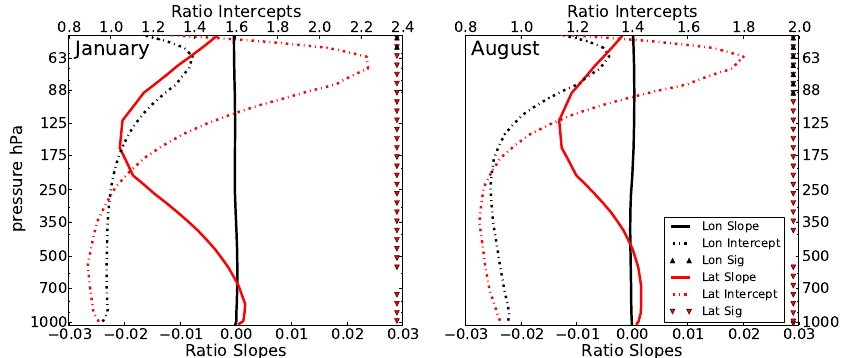
Fig. 6. same as Fig. 5 for August. Fig. 6. Same as Fig. 5 for August.